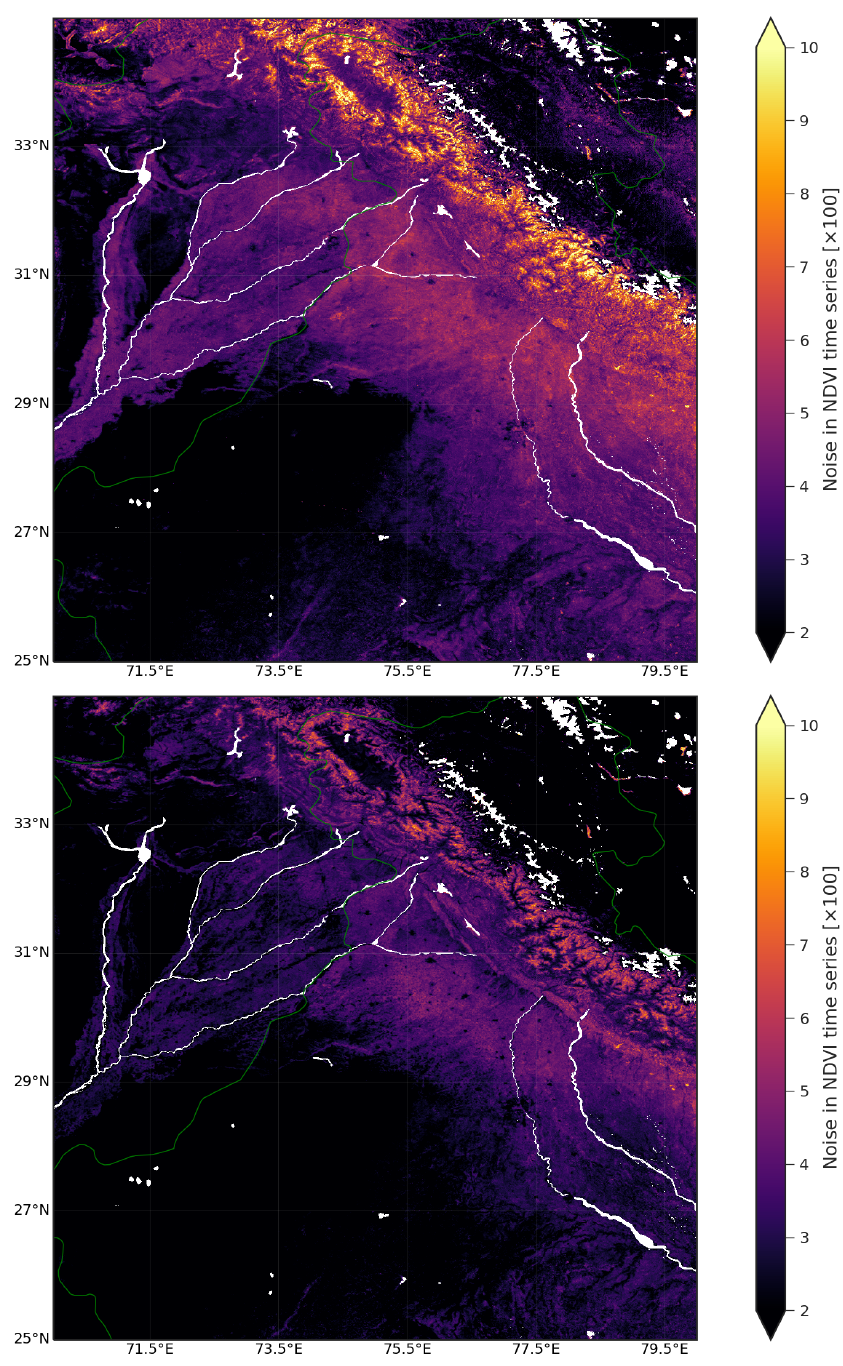
Figure 13. Same as in Figure 9 but for NDVI Time-Series ranging from 1999 to 2005.